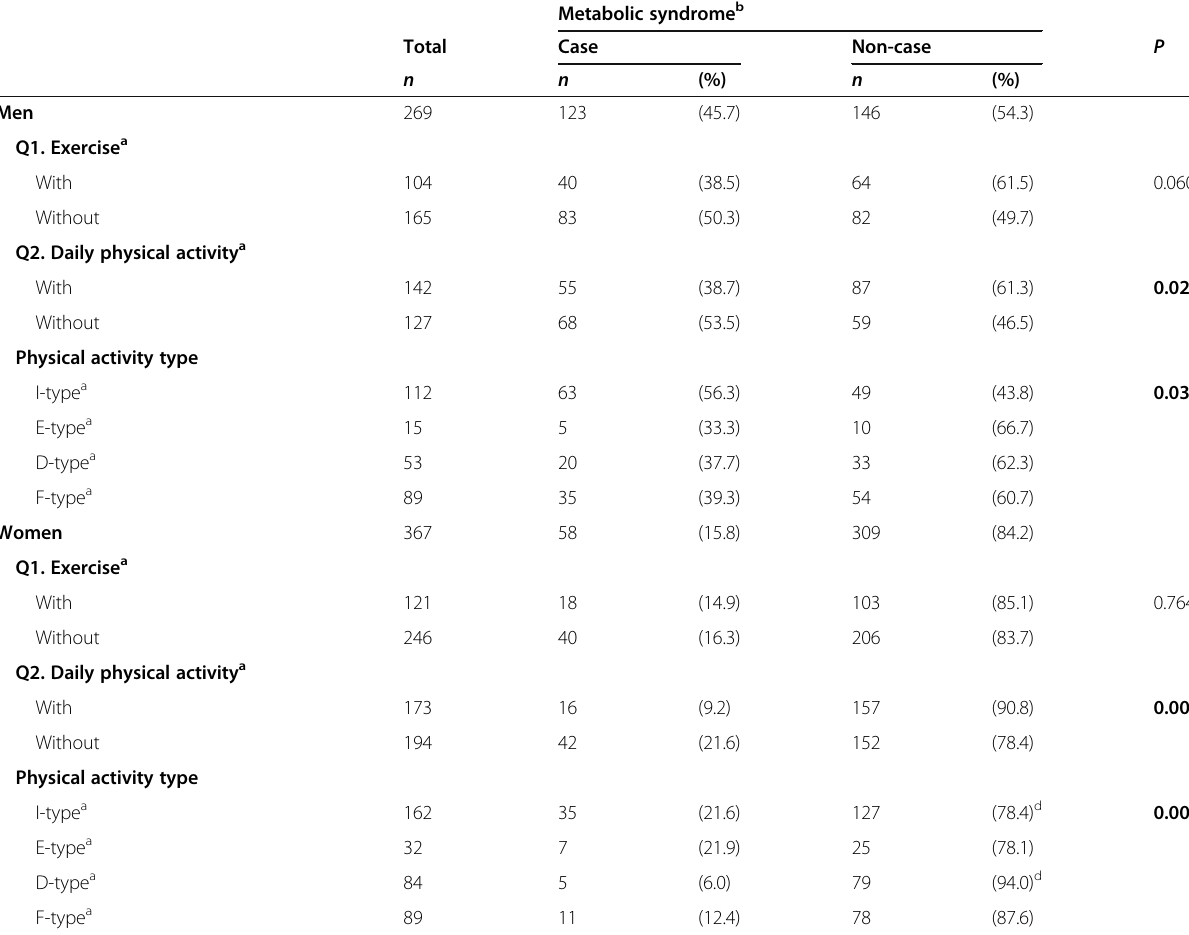
Table 3 Proportions of metabolic syndrome in analyses stratified by sex and physical activity